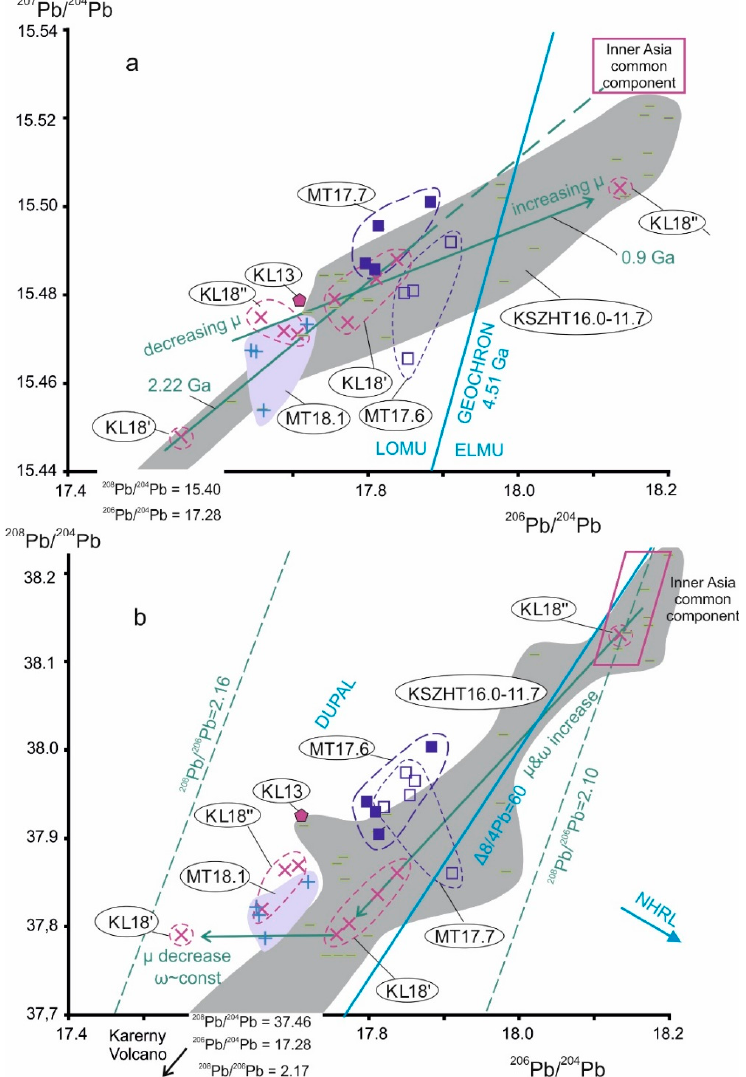
Figure 14. Diagrams of 207 Pb/ 204 Pb- 206 Pb/ 204 Pb ( a ) and 208 Pb/ 204 Pb- 206 Pb/ 204 Pb ( b ) for volcanic rocks from the KSZHT. Measurement errors of isotope ratios do not exceed icon sizes. On diagram a, shown are the Inner Asia common component and the geochron of Low μ Viscous Protomantle (LOMUVIPMA) with a slope corresponding to an age of 4.51 Ga, obtained for a source of volcanic rocks from the northwestern Udokan volcanic field in the reactivated part of the Siberian paleocontinent [94]. On diagram b , designated are the boundary of the DUPAL anomaly at Δ 8/4Pb = 60 [95] and estimated maximal 232 Th/ 238 U ratio (explanation in the text). Symbols are as in Figure 9.